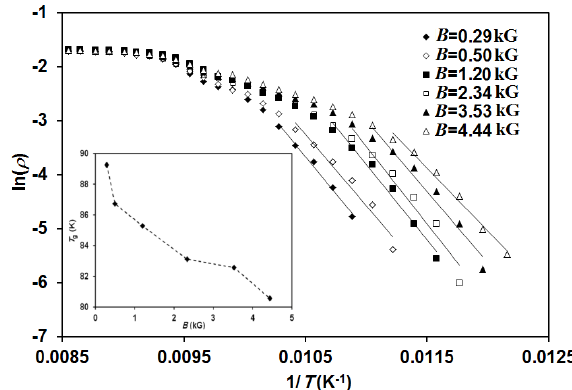
Fig. 5 ln( )  versus 1 /T plots for BiPb-2223 sample. The inset shows the applied magnetic field dependence of